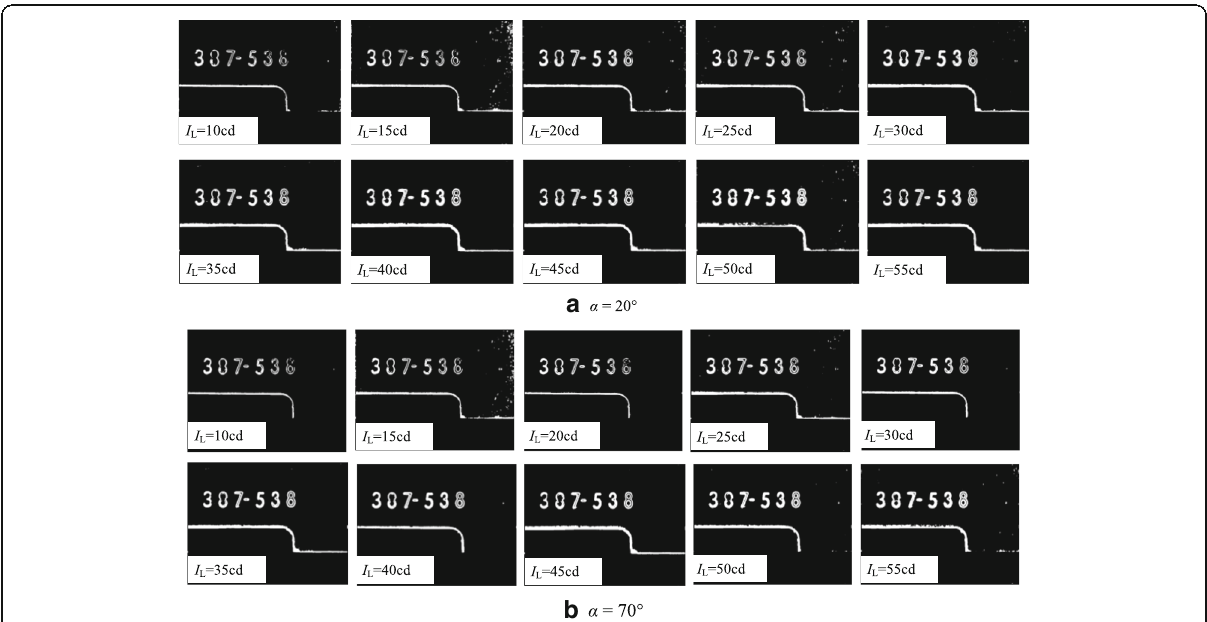
Fig. 10 a , b Image fusion results for different samples at different illumination intensity at α = 20° and